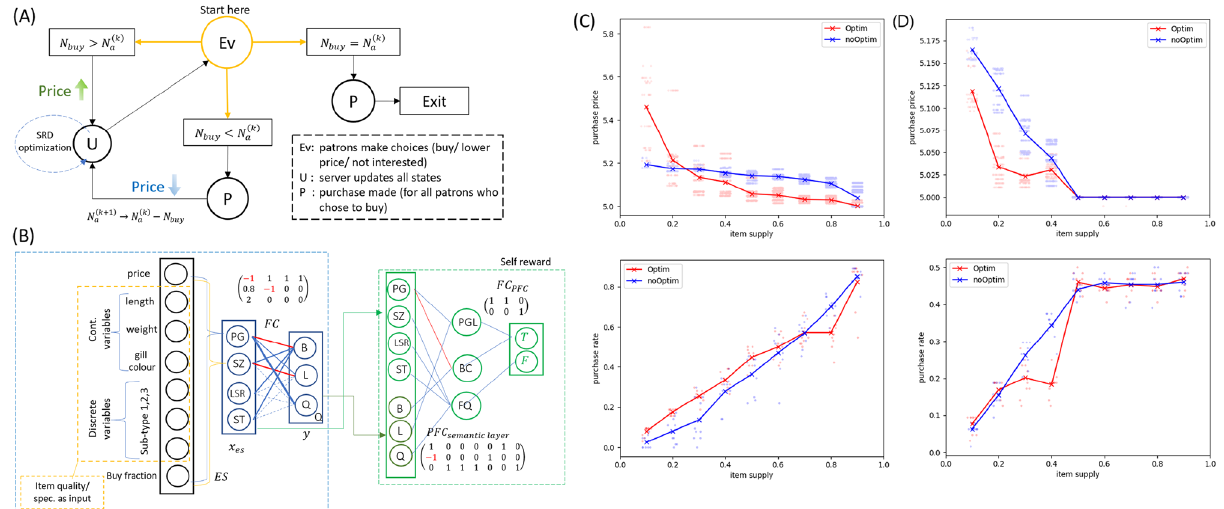
Figure 4. ( A ) Fish sale server. Ev: evaluation process. U: the states update process. P: updating records of successful purchases. ( B ) The Fish Sale Negotiator. ( C ) Optim (noOptim) denotes fish sale auction proceeding in which (no) SRD optimization is performed. Each dot in the background corresponds to an actual purchase price at a given item supply , whose value in the plot is slightly perturbed to show multiple purchases at similar prices. Top : purchase price vs item supply. With SRD optimization, the inverse trend (red) is more pronounced i.e. when there are much fewer fish available relative to the no. of patrons, the fish tends to be sold at a higher price. Bottom : purchase rate vs item supply, where purchase rate is the fraction of available fish sold. ( D ) Same as ( C ) but half the participants submit malicious models to the the price, l , w , g are continuous variables, respectively the length, weight, and gill colour normalized to 1 (higher